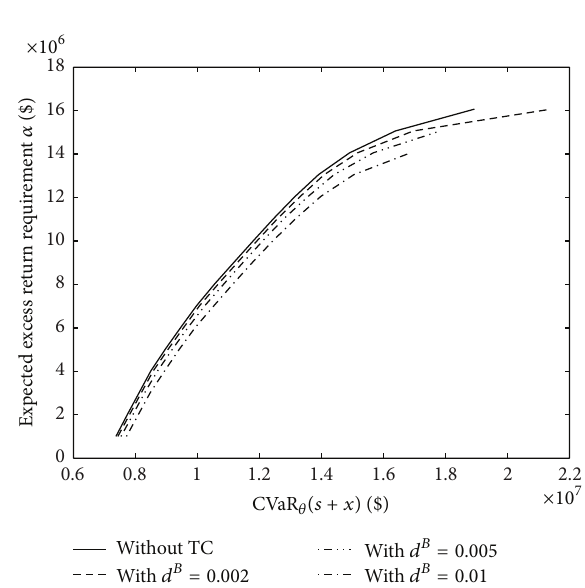
Figure 1: Return requirement 𝛼 -CVaR curve with and without transaction